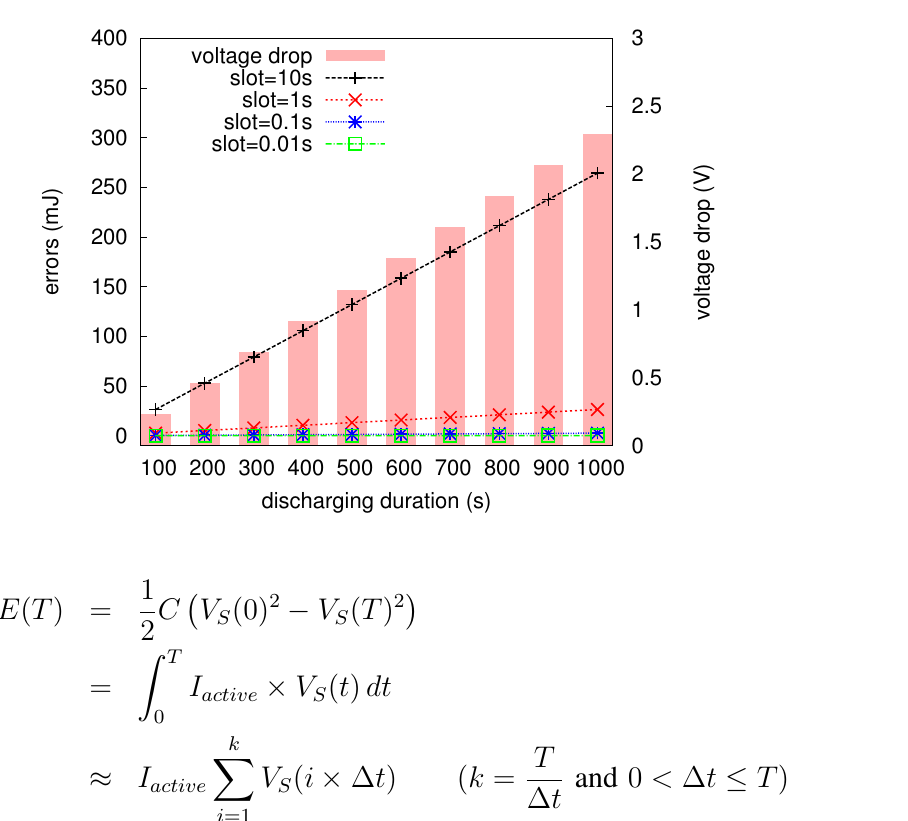
Figure 6. The voltage drops and the distributions of errors over different discharging